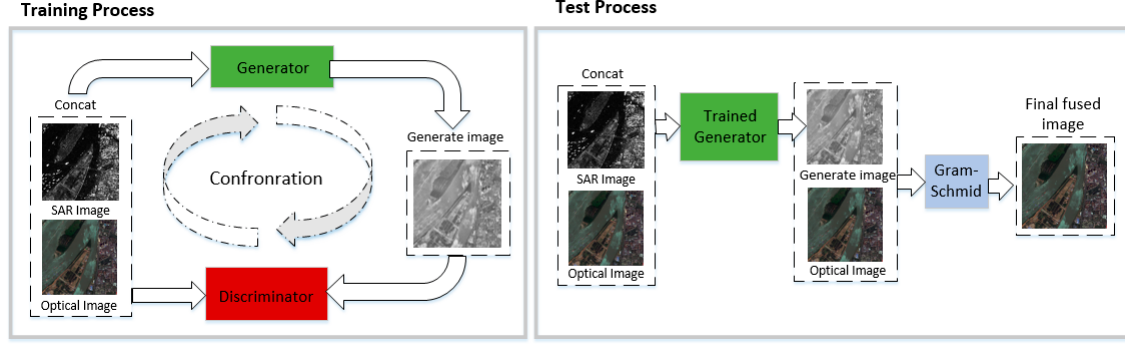
Figure 2. Framework of proposed fusion method.